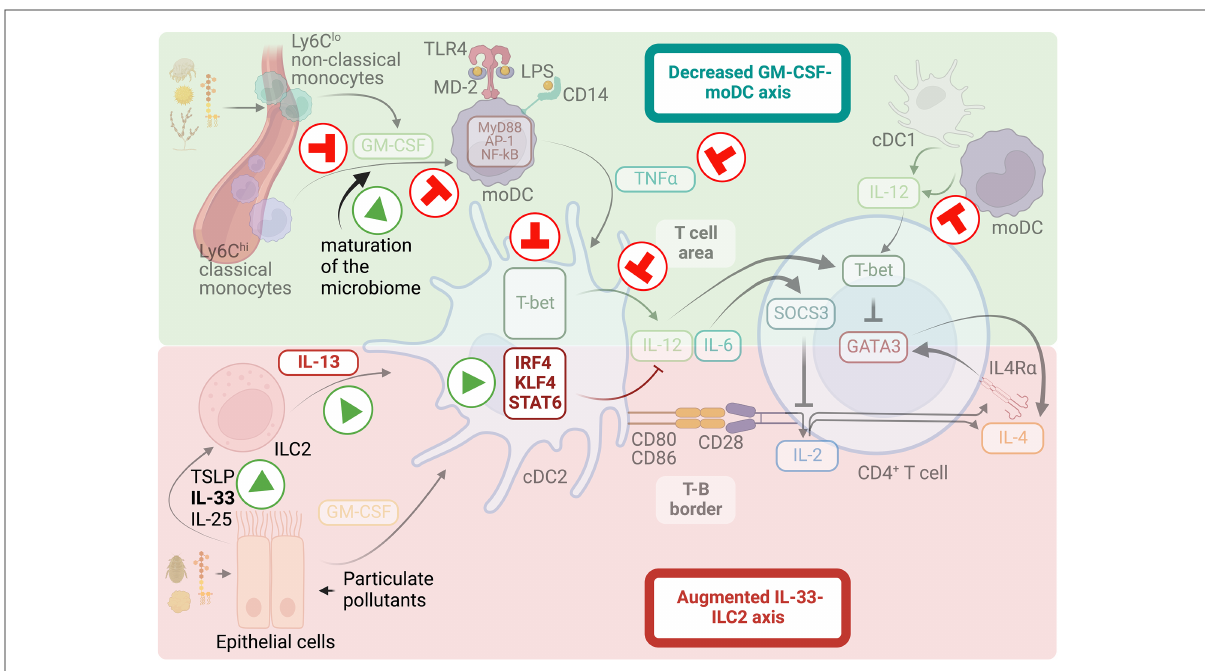
FIGURE 3 Mechanisms that favor Th2-biased immune responses at early ages. Infants and young children are at higher risk of developing Th2 cell allergic responses than adults. The lack of inhibitory signals and the intensi fi cation of triggering factors contribute to the increase in Th2-biased immunity and sensitization to allergens during early childhood. A malfunctioning GM-CSF-moDC axis conditions for LPS hyporesponsiveness during infancy, hindering the induction of T-bet expression on cDC2s and thus driving de fi cient IL-12 responses. Early dietary practices and exposure to environmental microorganism may shape the maturation of the infant microbiome into compositions that enhance the GM-CSF- moDC axis and protect against sensitization to airborne allergens. On the other hand, a hyperactive IL-33 axis operating in the lung during the early postnatal period increases IL-13 production by ILC2, which activates the migration and pro-Th2 function of cDC2s. Additionally, exposure to inhalable particulate pollutants can intensify this